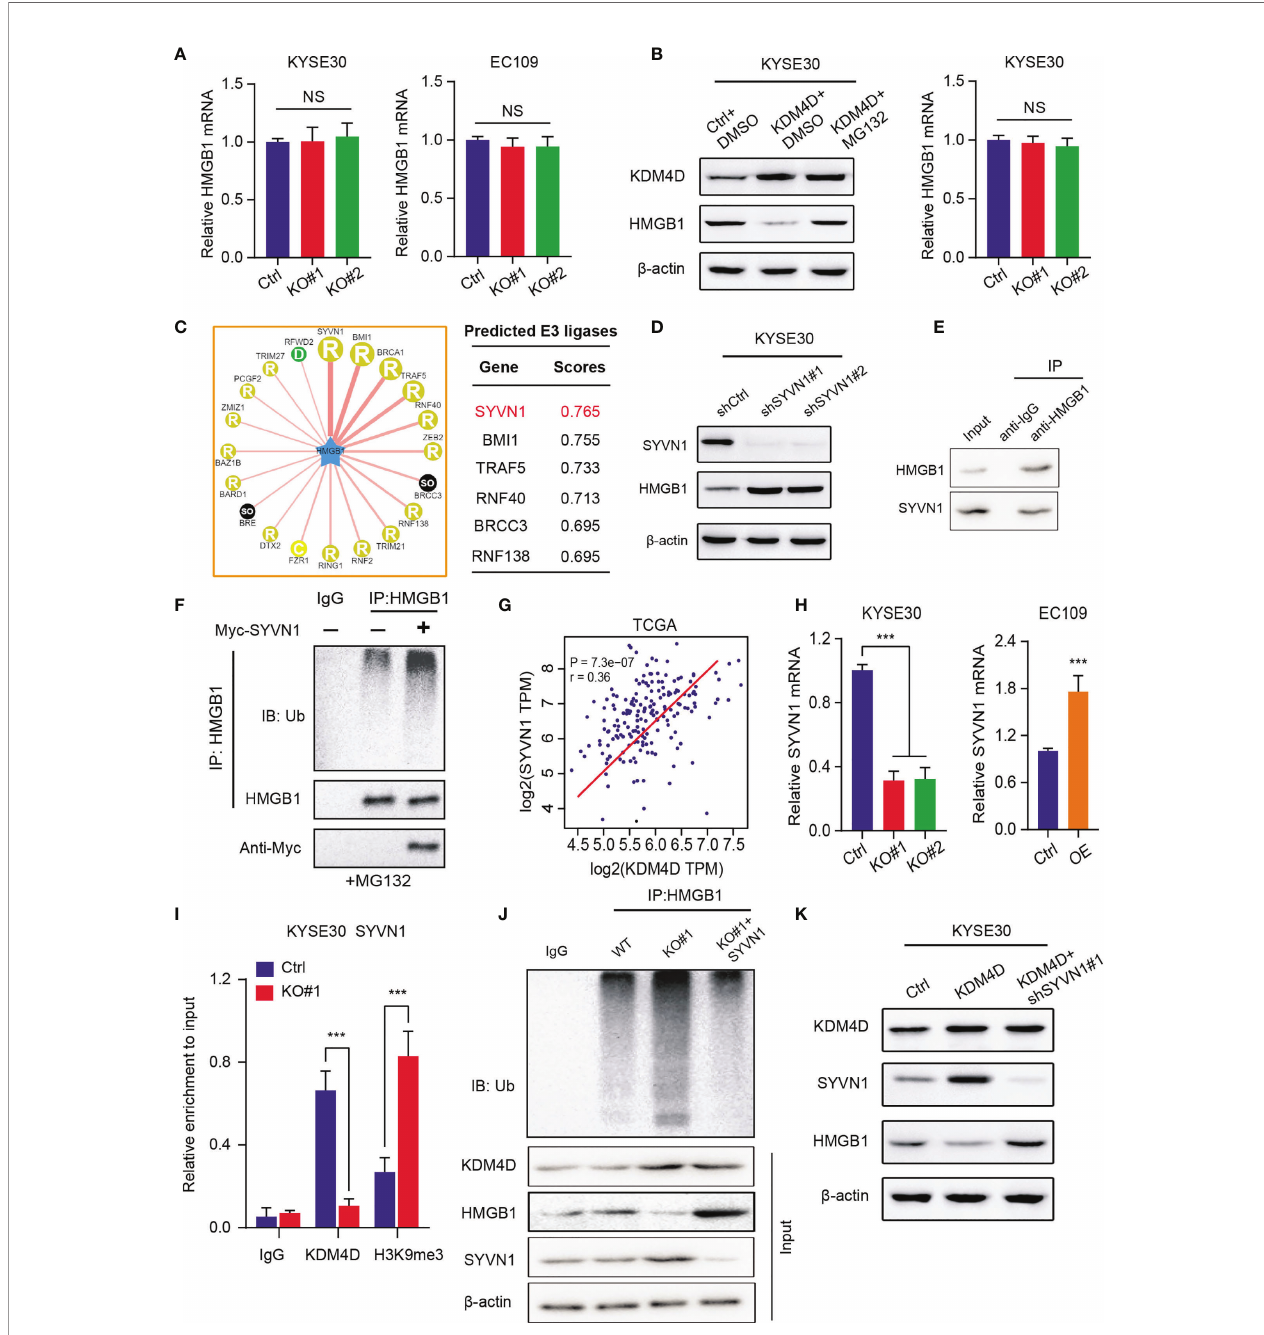
FIGURE 5 | KDM4D activates SYVN1 to promote HMGB1 degradation and restrict its protein levels. (A) Detection of HMGB1 mRNAs in Ctrl and KDM4D-KO cells (KYSE30 and EC109). (B) Detection of protein levels and mRNA levels of HMGB1 in three groups, including Ctrl+DMSO, KDM4D+DMSO and KDM4D+MG132. (C) Bioinformatic analysis for predicting E3 ubiquitin ligases that target HMGB1 for degradation based on the UbiBrowser dataset. (D) Western blot assays revealing the associations between SYVN1 and HMGB1. (E) Co-IP assay detecting the endogenous interactions between SYVN1 and HMGB1. (F) Western blot of the products of in vitro ubiquitination assays from 293 T cells transfected with the indicated plasmids and treated with 20 m M MG132 for 8 h. (G) Correlation analysis revealing the associations between KDM4D and SYVN1 mRNA levels in TCGA-ESCC cohort. (H) Detection of SYVN1 mRNA levels in different groups, as indicated. (I) The ChIP-PCR was conducted to con fi rm the occupancy of KDM4D and H3K9me3 modi fi cation at the SYVN1 promoter in KYSE30 cells. (J) Western blot of the products of in vitro ubiquitination assays from 293 T cells transfected with the indicated plasmids and treated with 20 m M MG132 for 8 h. (K) Western blot assays revealing the associations across KDM4D, STVN1 and HMGB1 in three groups, including Ctrl, KDM4D and KDM4D+shSYVN1#1. *** P < 0.001. NS, No Signi fi